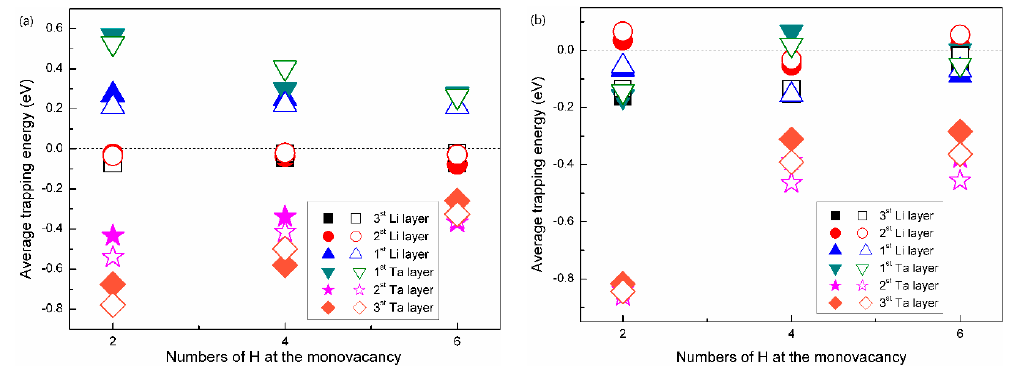
Figure 8. The average H-trapping energy as a function of numbers of the H atoms in the mono-vacancy in ( a ) Li(100)/Ta(100) and ( b ) Li(110)/Ta(110) bilayers. The hollow patterns represent the trapping energies with the ZPE corrections, while those solid ones not. According to the definition of the H trapping energy, the interstitial H atoms for reference can lie at the first, second and third layers (the nearest layer to the interface is recognized as the first layer, and so on). The vacancy was set on the second Li or Ta layers.